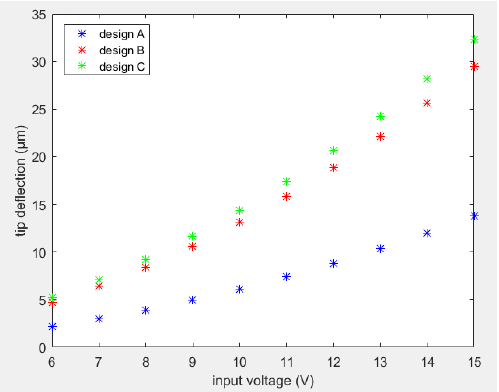
Figure 14. Tip deflection of design C in function of length ratio between two arm structures and the